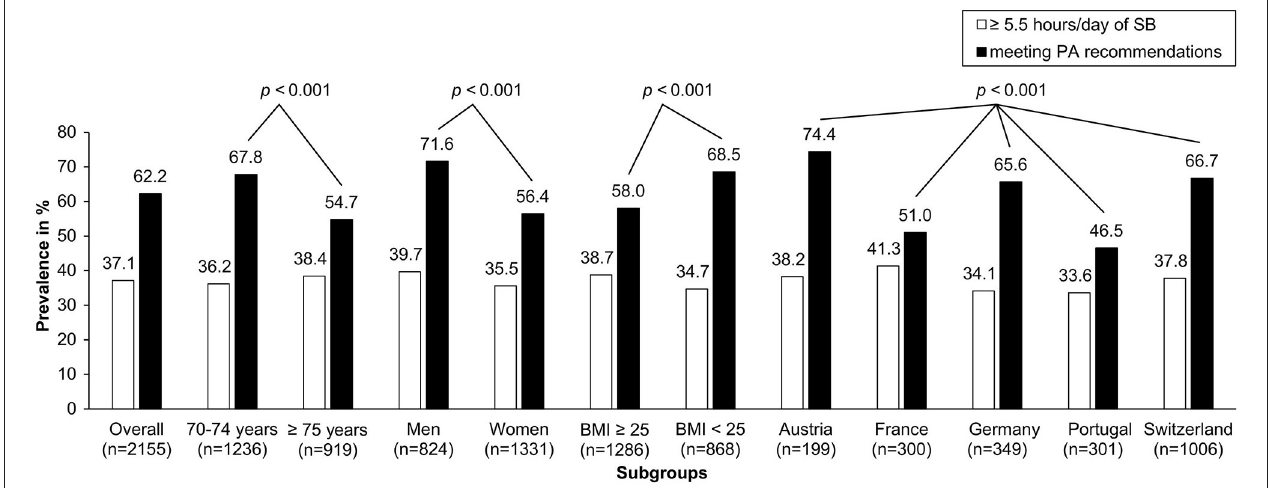
FIGURE 1 | Prevalence of participants meeting PA recommendations and prevalence of participants spending ≥ 5.5 hours/day with SB; in %, per subgroup. For BMI, data of 2,154 participants was available. P -values for comparisons within subgroups are from Chi-Square Tests meeting PA. For SB, none of the comparison within subgroups were significant.